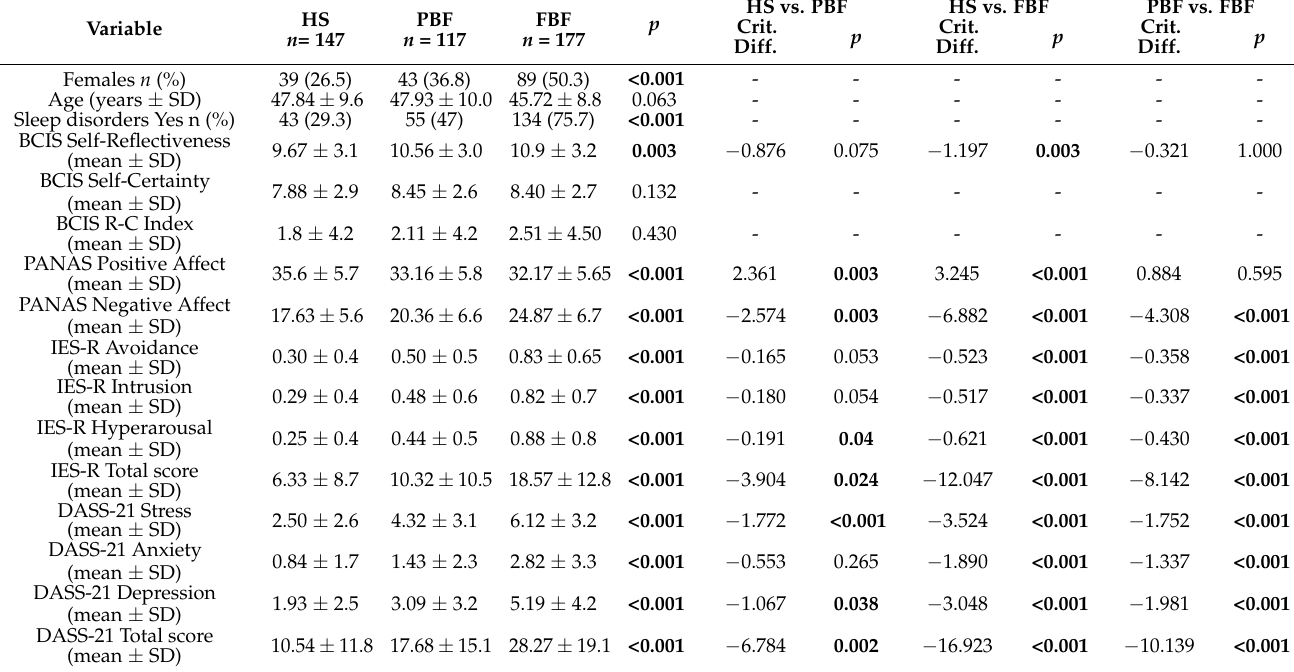
HS = Healthy Subjects; PBF: Probable Brain Fog; FBF: Functional Brain Fog. BCIS = Beck Cognitive Insight Scale; PANAS = Positive Affect and Negative Affect Schedules; IES-R = Impact of Event Scale-Revised; DASS-21 = De- pression Anxiety Stress Scales-21; SD = standard deviation; crit. diff. = critical difference. Significant values ( p < 0.05) are highlighted in